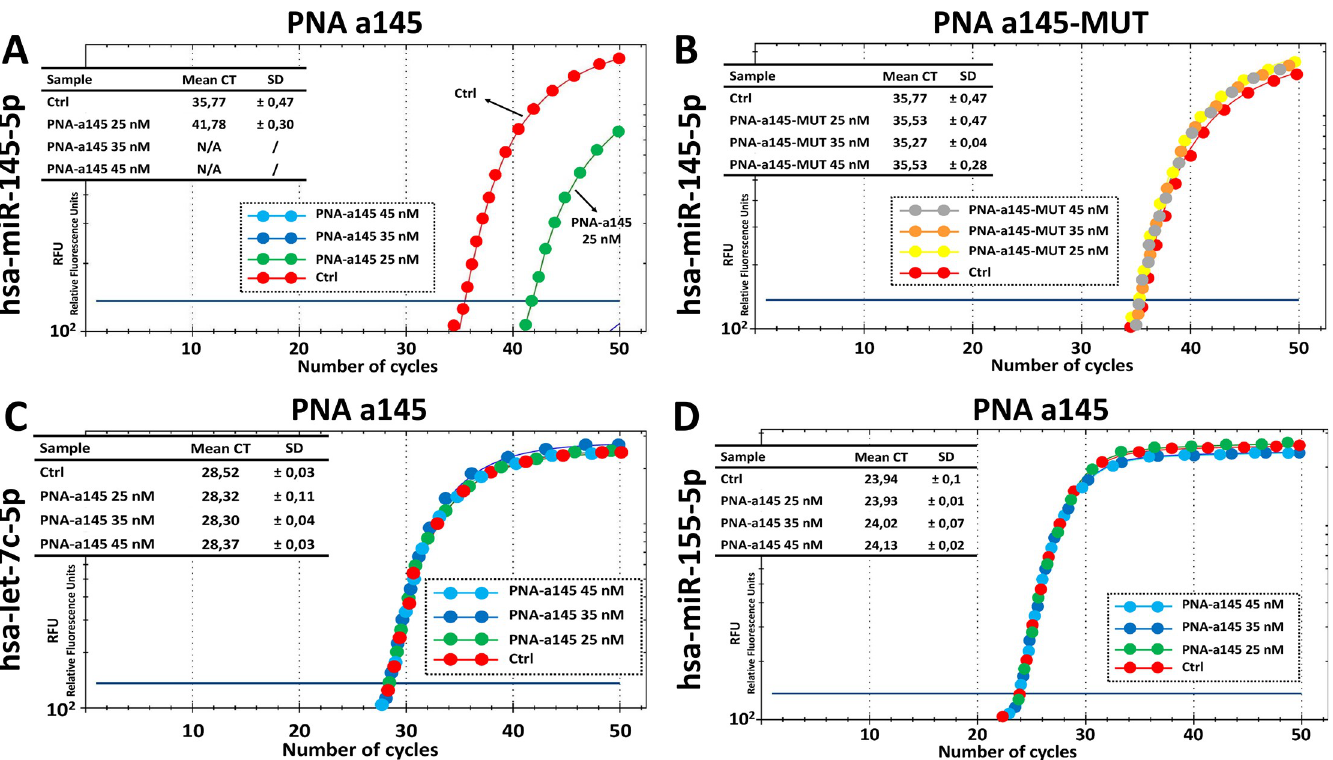
Fig 4. Effects of the PNA-a145 on the RT-PCR amplification of miRNA sequences. A,B. Effects of 25 nM PNA-a145 (A) and mutated PNA-a145-MUT (B) on the amplification of miR-145-5p sequences. C,D. Effects of 25 nM PNA-a145 on the amplification of miR-155-5p (C) and let-7c-5p (D) sequences. A summary of increasing concentrations of PNA-a145 are presented in Figure F in S1